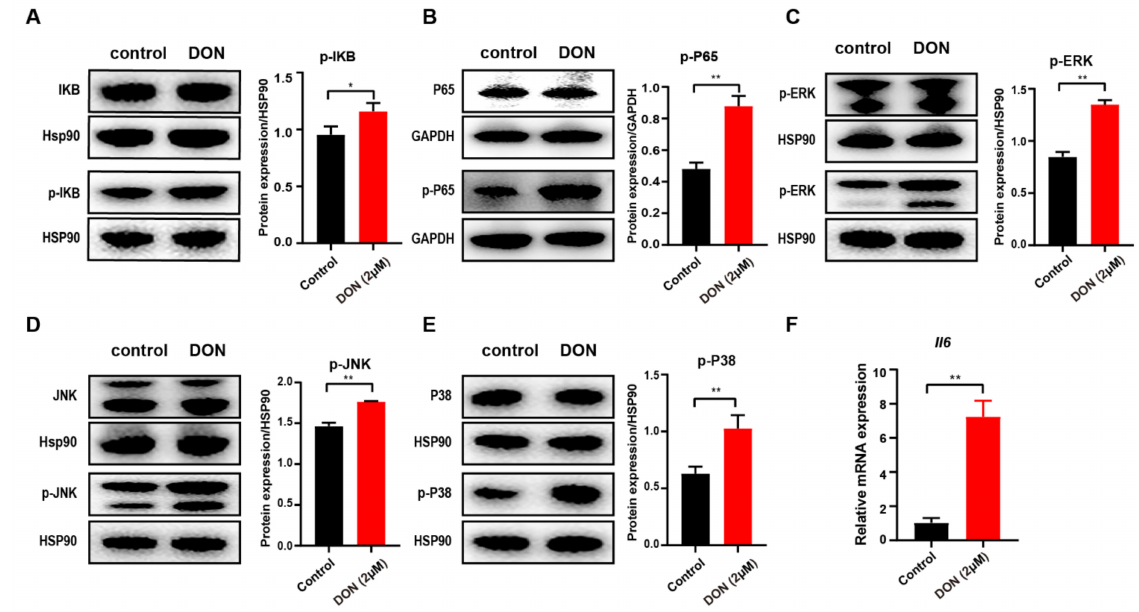
Figure 6. DON-induced NF- κ B and MAPK activation in murine ovarian granulosa cells. Ovarian GCs were stimulated with DON for 24 h. ( A ) IkB α (1:1000 dilution) and p-I κ B α (1:1000 dilution). ( B ) P65 (1:1000 dilution) and p-P65 (1:1000 dilution). ( C ) ERK (1:1000 dilution) and p-ERK (1:1000 dilution). ( D ) JNK (1:1000 dilution) and p-JNK (1:1000 dilution). ( E ) P38 (1:1000 dilution) and p-P38 (1:1000 dilution). ( F ) The relative gene expression of Il6 in GCs with and without DON treatment. All data are shown as mean ± SD, n = 3. * p < 0.05 and ** p < 0.05 compared with the